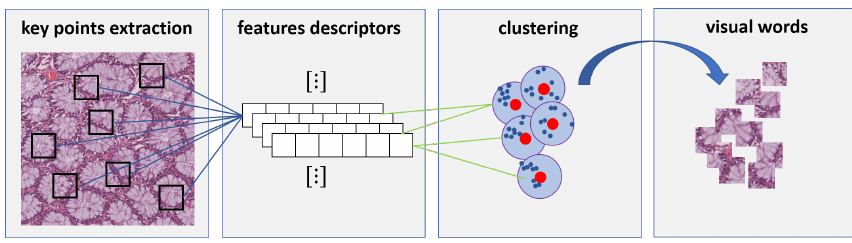
Figure 8. Bag of features approach: image